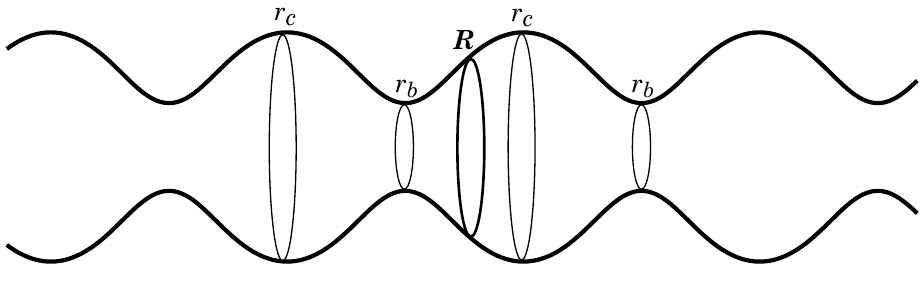
Figure 2. The oscillation of radius r in the constant- τ slice. The 2-spheres are shown by circles. Starting from the boundary at R , the radius may initially increase (decrease), reach r c ( r b ) and continue past that. A horizon or an RP 2 may lie on any neck or waist with radius r b or r c , respectively. Four possible cases involving the least number of oscillations are